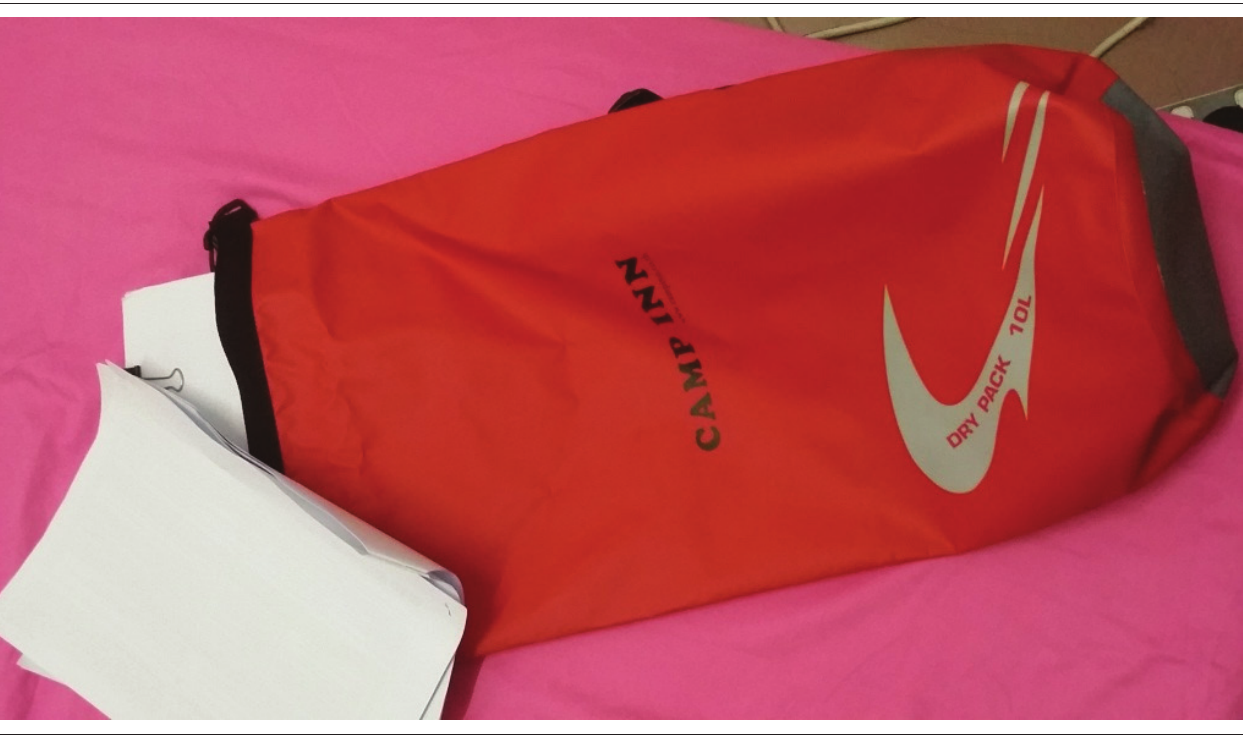
FIGURE 6: Keeping important documents or even electronic gadgets in a waterproof bag – This bag can serve as a grab bag as